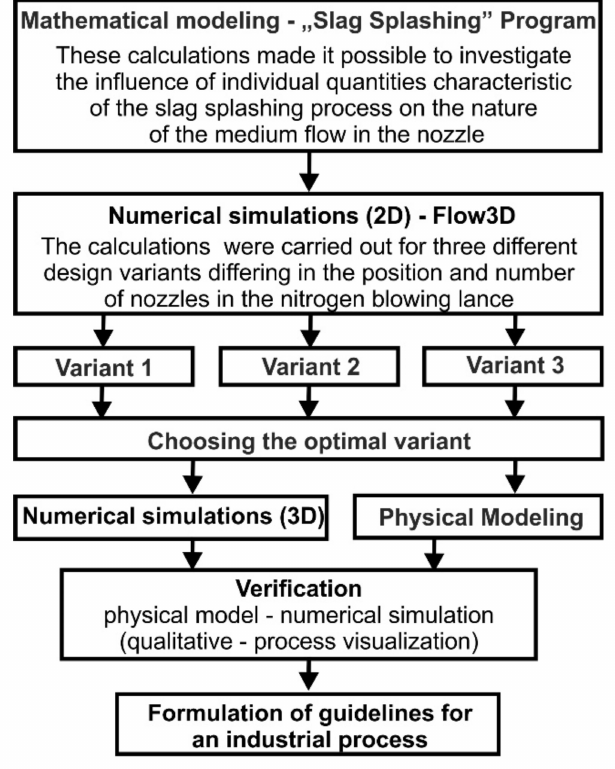
Figure 2. Scheme research